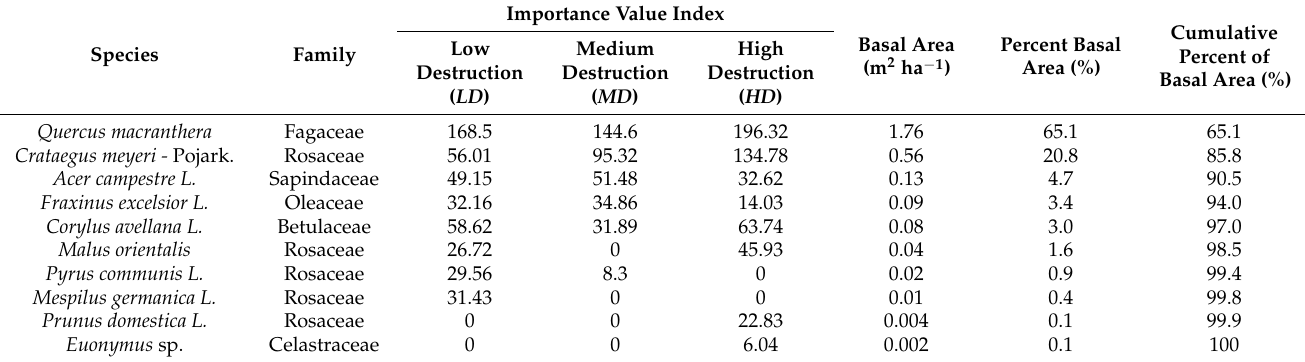
Table 2. Tree (DBH ≥ 5 cm and height ≥ 1.5 m) composition and structure by species in a naturally-regenerated broadleaf forest in the Arasbaran biosphere reserve in Iran ( n = 30). The Important Value Index are presented by a destruction class. Equations for the Importance Value Index and Basal Area are listed in Table 1. Destruction classes were developed with a Disturbance Index ( DI ) that incorporated levels of observed human impact (few too many signs of cutting and grazing livestock) (see methods). For context, LD is near to the desired reference condition, but it is not the target for a management implication. Cumulative is a summation of the Percent Basal Area